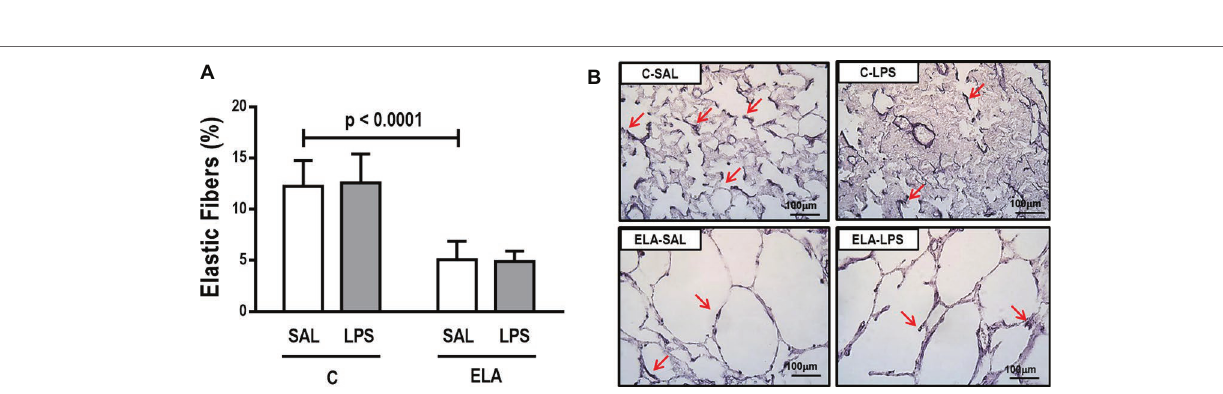
FIGURE 5 | Collagen fiber content and representative photomicrographs of (A) alveolar septa, (B) airways, and (C) pulmonary vessel wall stained with the Picrosirius-polarization method (collagen fibers). C, control; ELA, animals treated with intratracheal instillations of elastase; SAL, saline; LPS, E. coli lipopolysaccharide. Values are mean ± SD of six animals in each group.